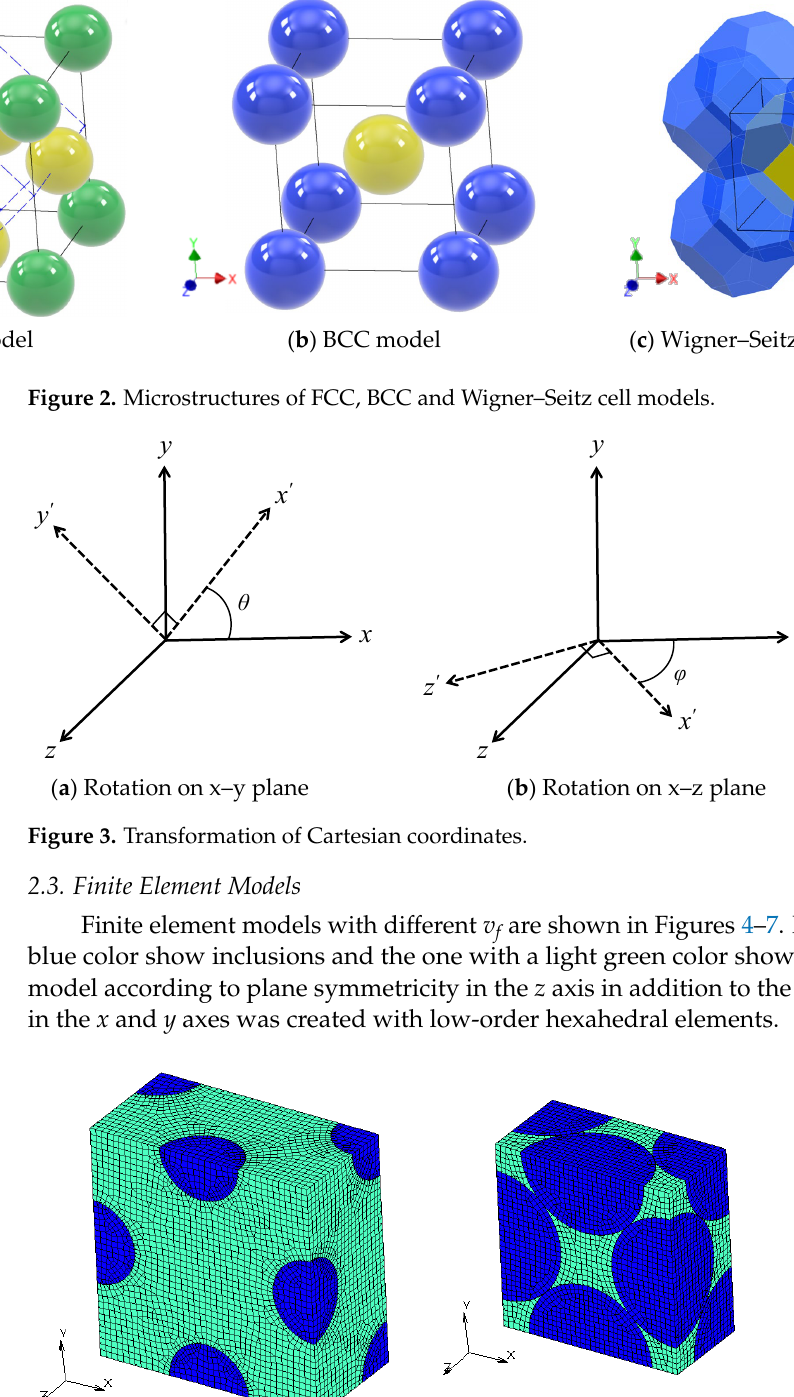
Figure 4. Numerical models of FCC microstructures with different volume fractions v f .